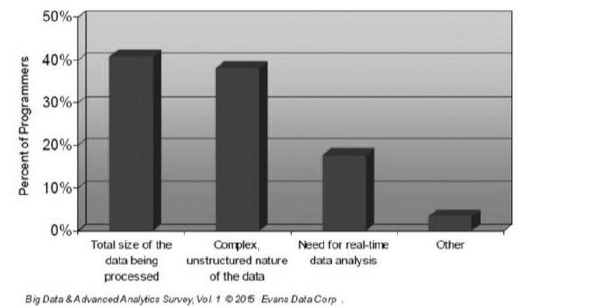
Figure 3. Top three factors driving big data